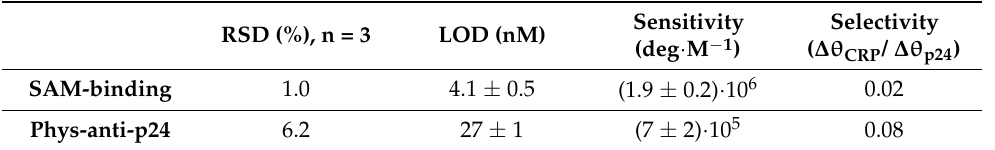
Table 4. Summary of the analytical figures of merit of the two biomodification methods with anti-p24 for the detection of the p24